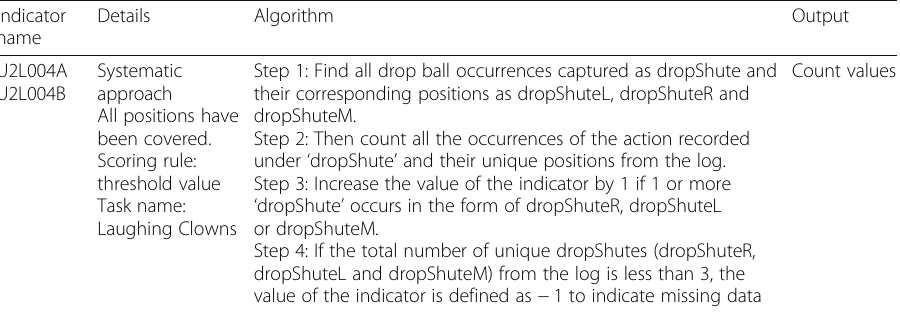
Table 3 Use of algorithm to relate actions to the element systematicity of the collaborative problem-solving construct (adapted from Adams et al.